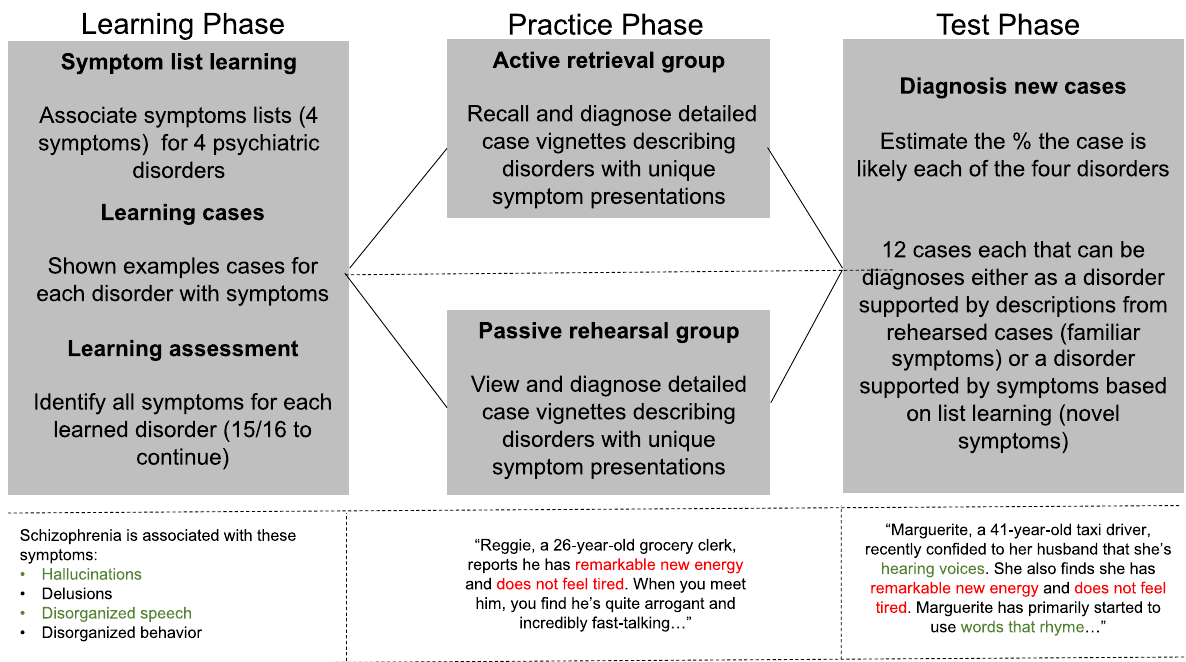
Fig. 1 A schematic of the experimental design with an example of the presented stimuli used in each phase provided below for illustrative purposes. Used case vignettes also included diagnostically irrelevant, case-specific information (e.g., familial status, location of residence, etc.). Practice example case vignettes contained all four symptoms of the relevant diagnosis. Test case vignettes contained two familiar symptom descriptions supporting one diagnosis from the practice cases and two novel symptom descriptions supporting another